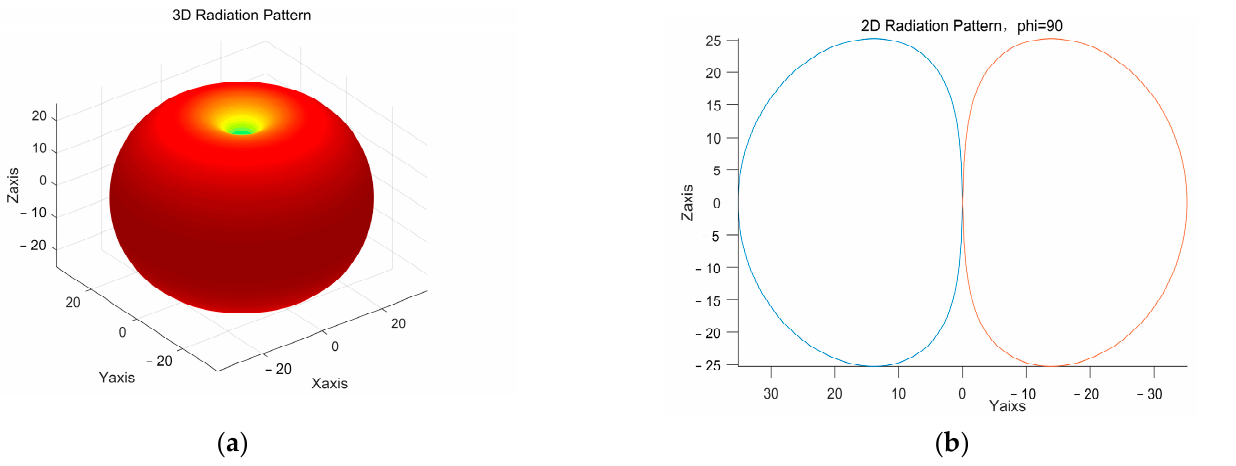
Figure 18. Pattern of the ME antenna: ( a ) 3D radiation pattern and ( b ) principal gain (phi = 90) pattern.